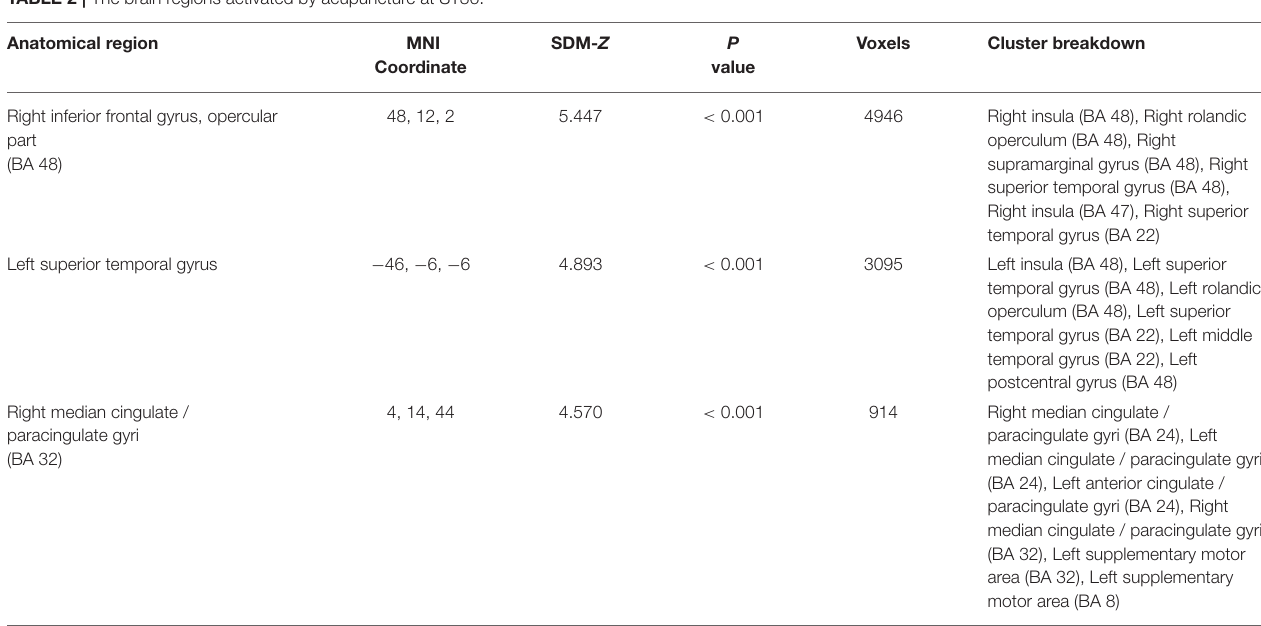
TABLE 2 | The brain regions activated by acupuncture at ST36. Anatomical